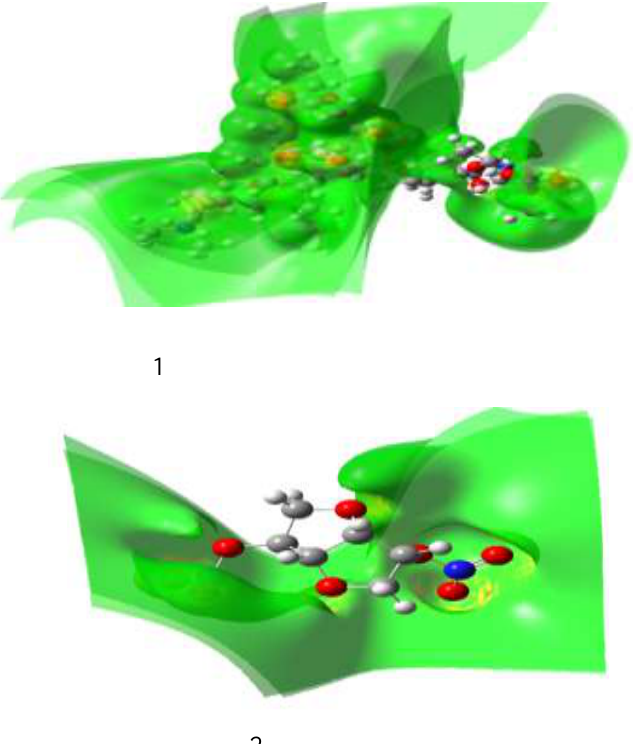
Figure 14: ESP map of the studied